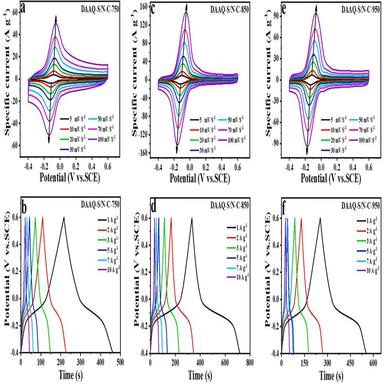
(a, c, e) CV curves at varied scan rates from 5 to 100 mV s − 1 and (b, d, f) GCD profiles at different current densities from 1 to 10 A g− 1 of DAAQ-S/N-C-750, DAAQ-S/N-C-850, DAAQ-S/N-C-950 electrodes in aqueous 1 M H2SO4 electrolyte.